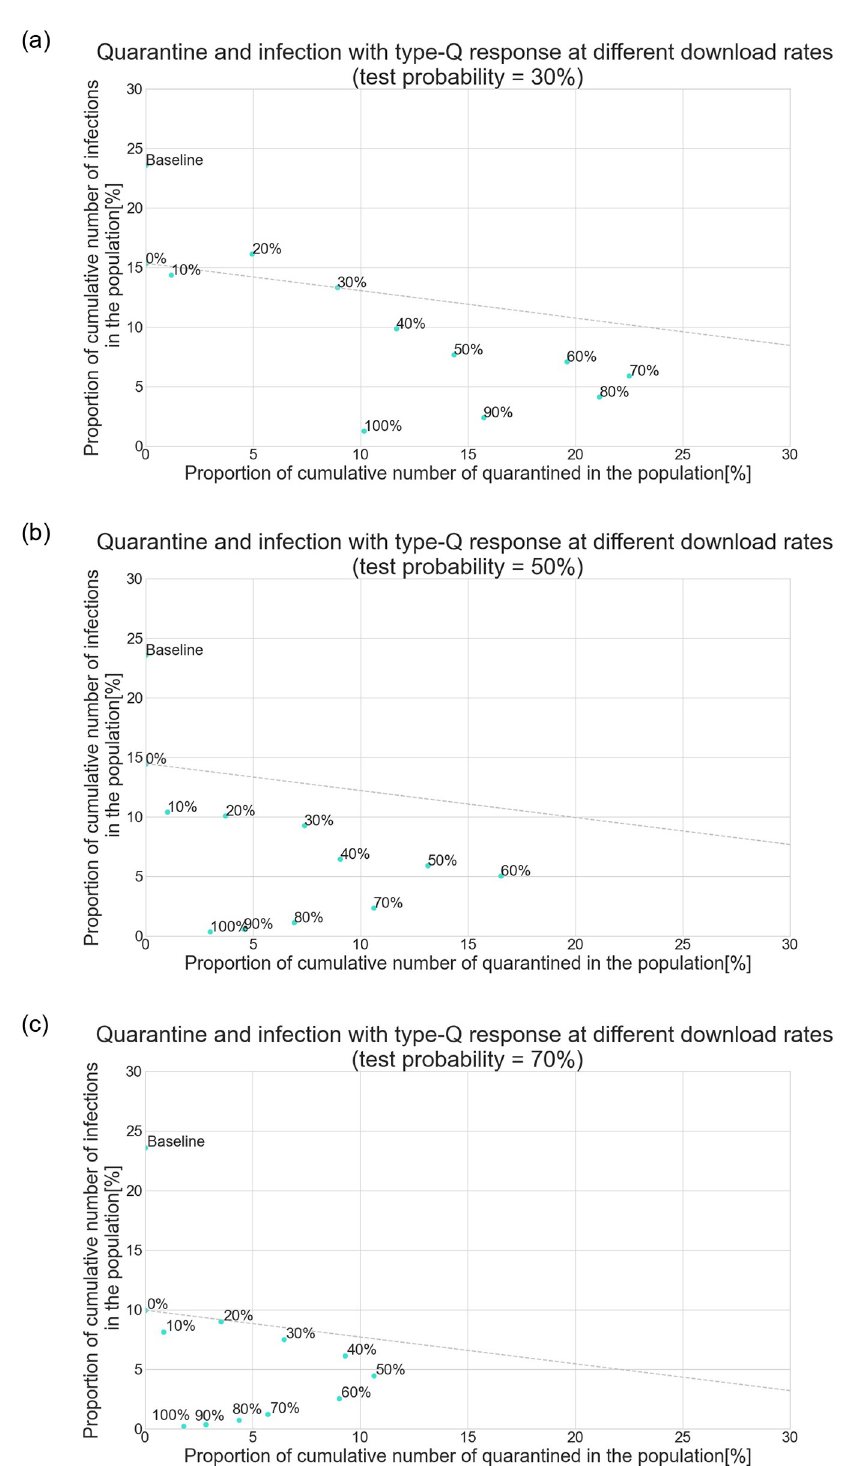
Fig 4. Quarantine and infection when the download rate of apps is varied and type-Q response is applied. (a) Scenario of 30% test probability. (b) Scenario of 50% test probability. (c) Scenario of 70% test probability.